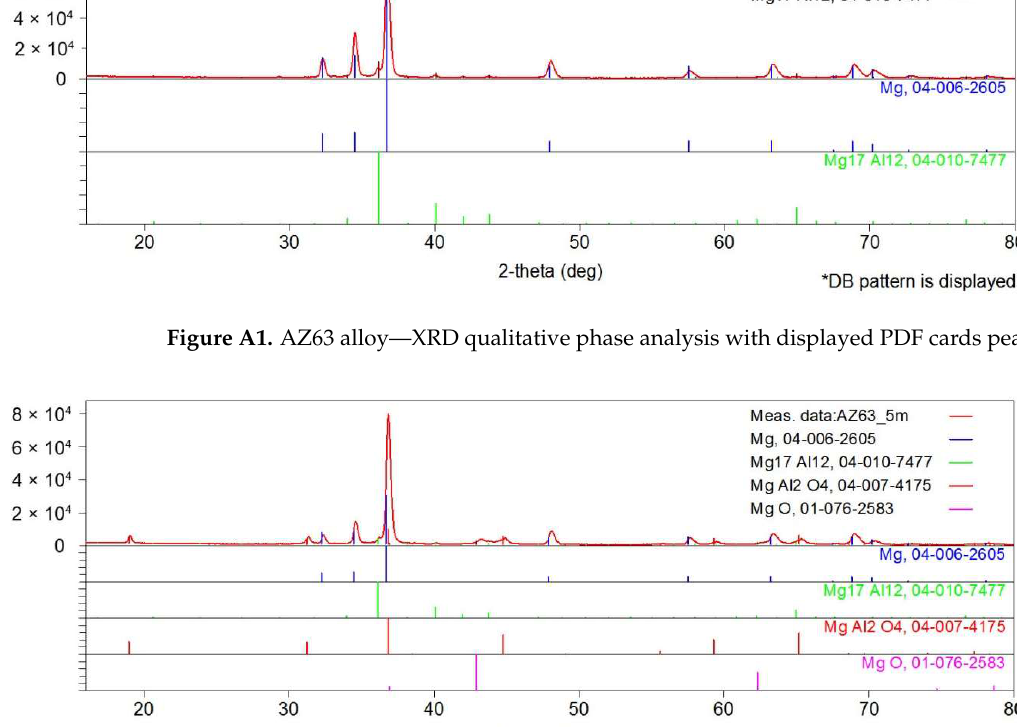
Figure A3. AZ63_10m sample—XRD qualitative phase analysis with displayed PDF cards peak bars. Figure A4. AZ63_20m sample—XRD qualitative phase analysis with displayed PDF cards peak bars.